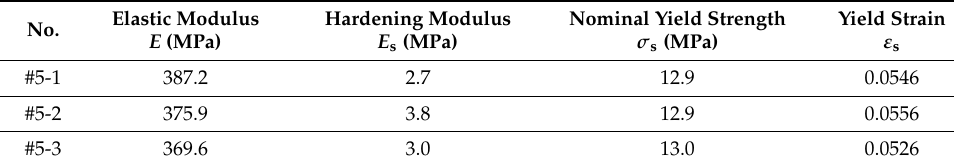
Table 2. Main material parameters of the PTFE/Al/Si reactive